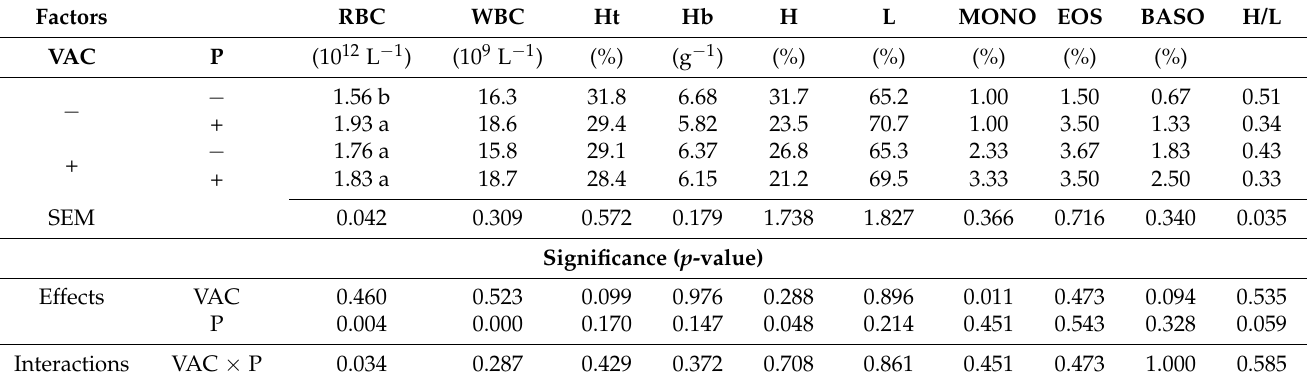
Table 3. Haematological parameters and leukogram in the chicken blood collected at 16 d of age.